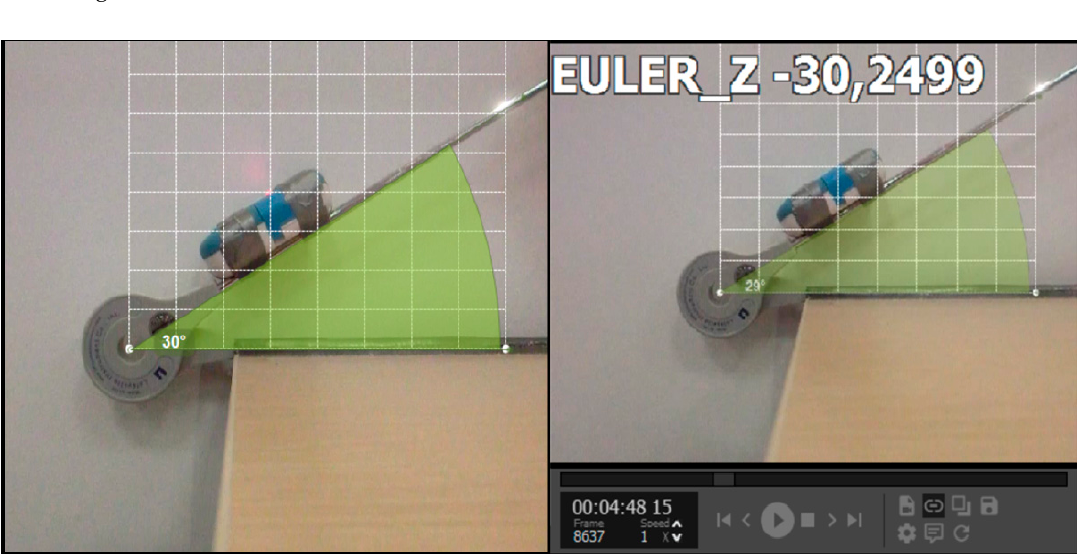
Figure 1. Procedure of Phase 1. The left image shows the inertial device attached to the goniometer, the position of the camera, and the automatic tracking function of the Kinovea calculating the angle. On the right, QÜIKO software automatically calculates the same